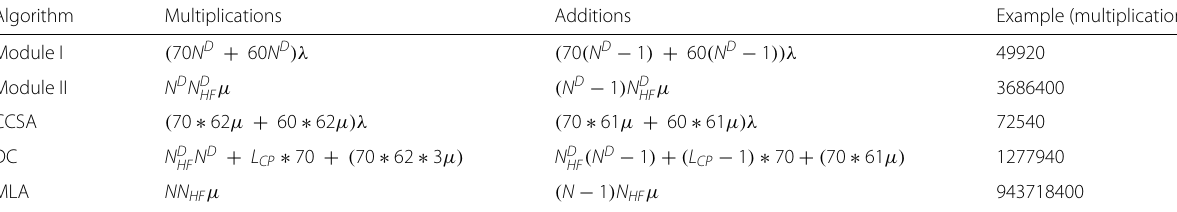
at 5, module I performance almost approaches to that of module II in the absence of IFO. The CDF of successful detection of SID over the number of frames is presented in Fig. 7. The results show that the chances of detecting SID at − 6 dB SNR in first half frame is of